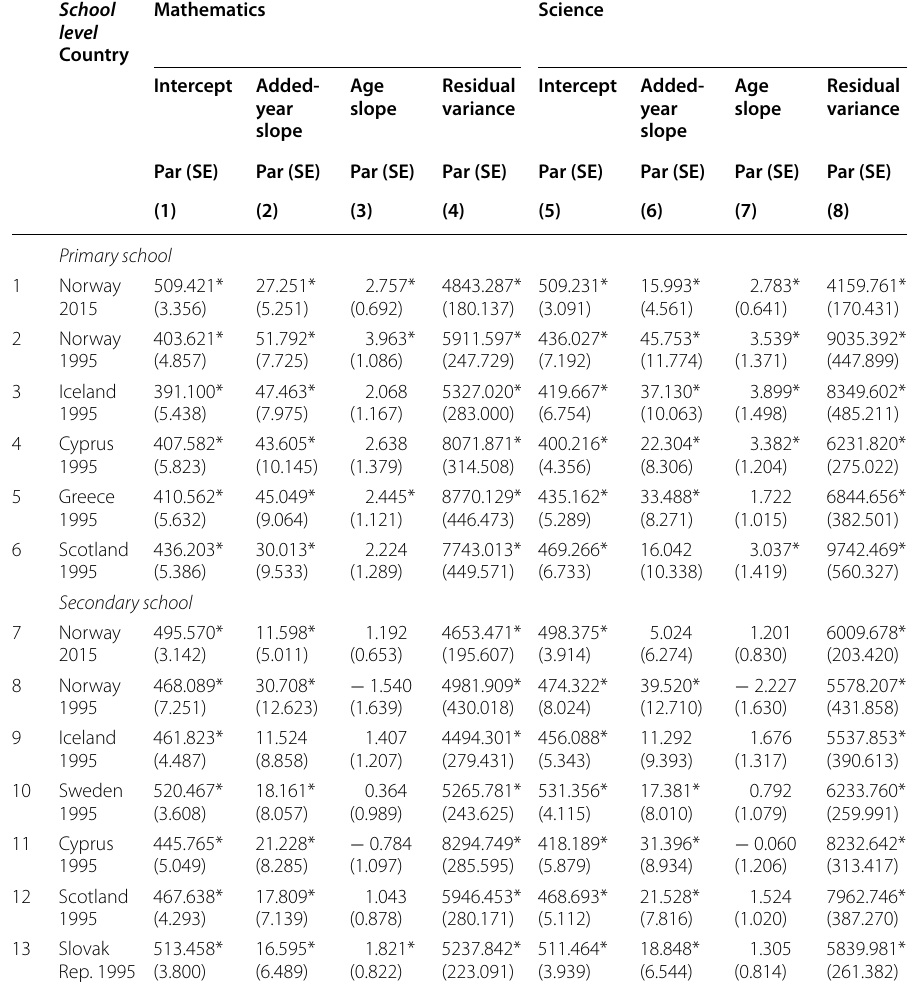
The rows depict the results of the regression model described in Eq. (1) with a reduced age bandwidth (six months before and after threshold) for the different samples. The columns depict the parameters with standard errors (SE) in parentheses. The analyses are based on unstandardized achievement scores * p <